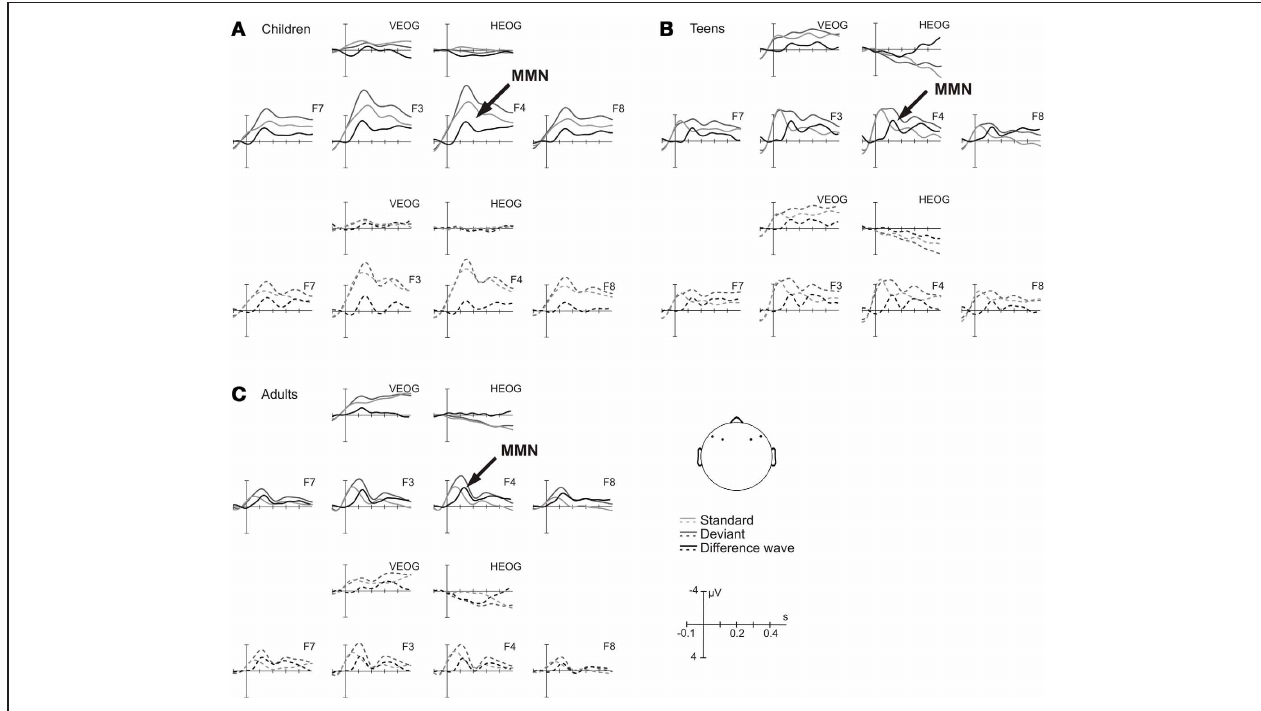
group, solid lines depict waves for a simulated motion to the left, dashed lines for a simulated motion to the right at selected electrodes: F7, F3, F4, and F8, respectively. Vertical and horizontal eye electrodes: VEOG and HEOG. Data were 7Hz low pass filtered for visualization